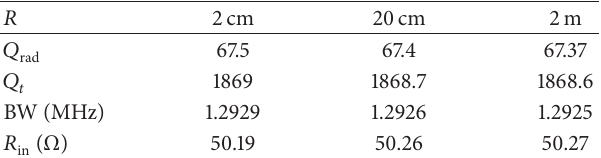
Table 1: 𝑄 , 𝑄 𝑡 , BW, and 𝑅 rad